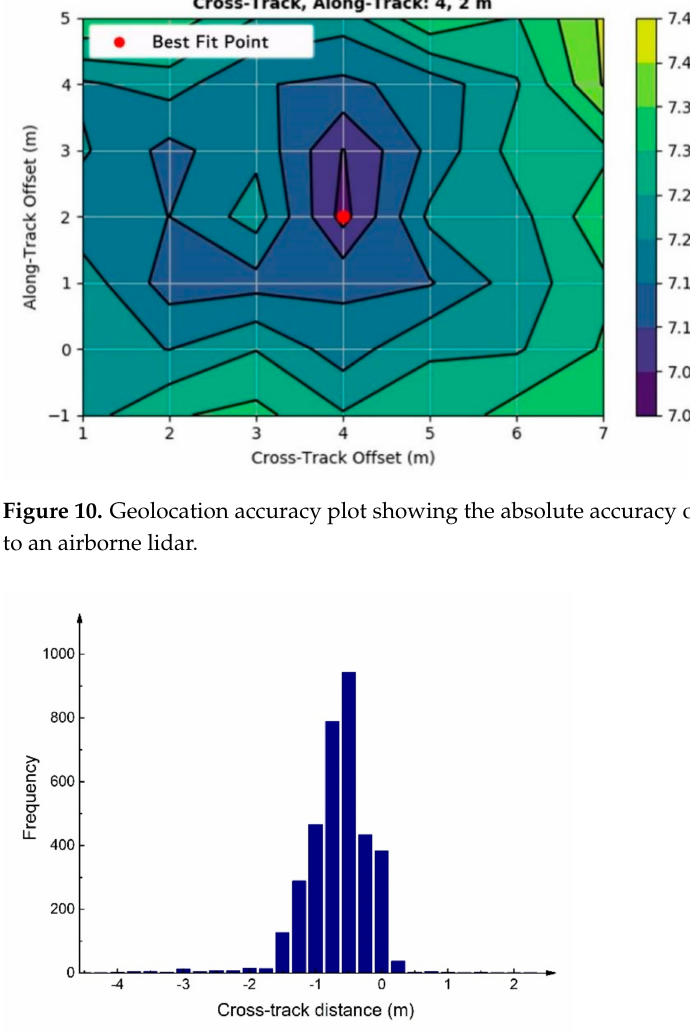
Figure 11. Frequency histogram of the cross-track distance of ATL03